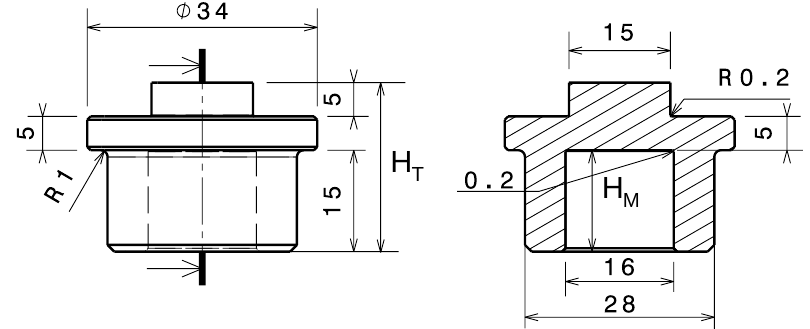
Figure 16. Geometry of the target for the dynamic shear